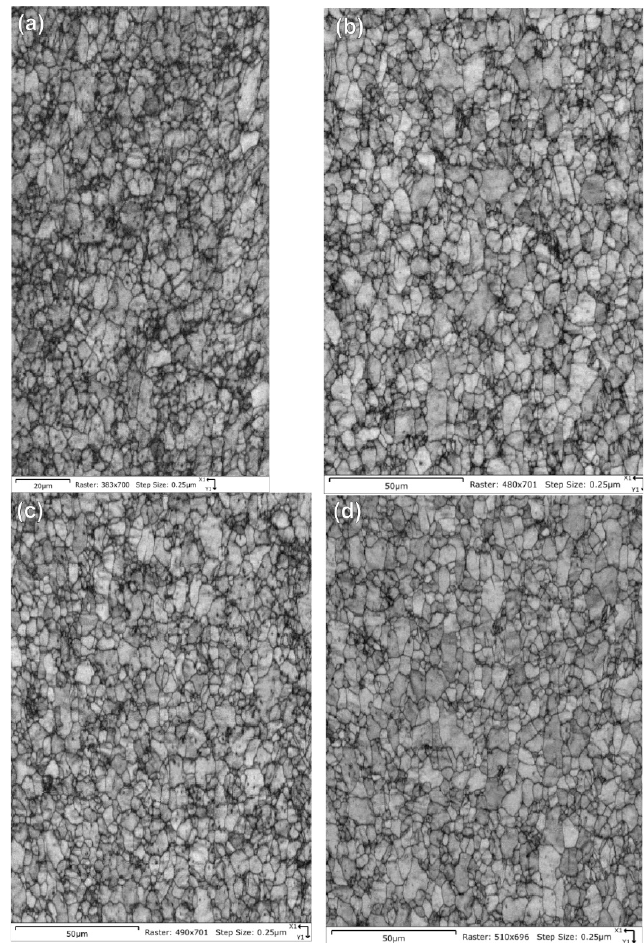
Figure 16. Pattern quality maps are provided for the NPG tubes: ( a ) Tube a-1-05, ( b ) Tube a-2-05, ( c ) Tube d-7-05 and ( d ) Tube d-8-05. The maps do not show significant differences other than a slightly fuzzier grain boundary contrast for tube a-1-05 due to a poorer final surface finish.